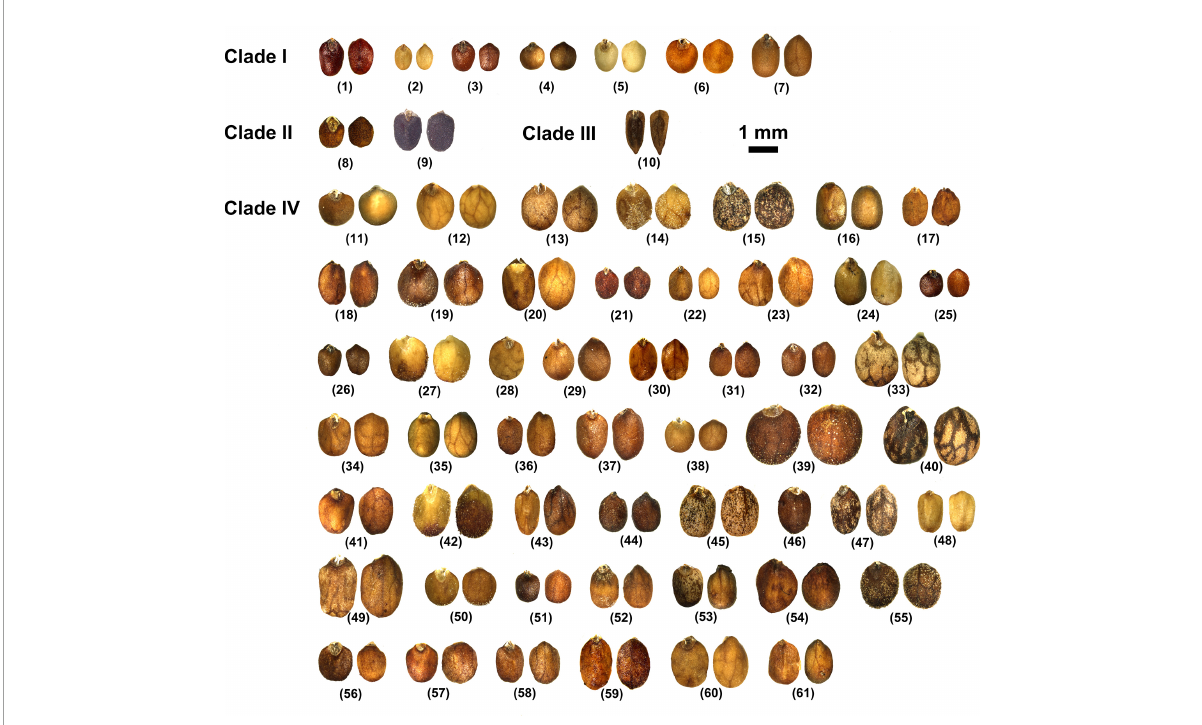
FIGURE3 Nutlet morphology of taxa of Isodon . (1) I. atroruber ; (2) I. lophanthoides var. lophanthoides ; (3) I. lophanthoides var. graciliflorus ; (4) I. oreopilus ; (5) I. phyllopodus ; (6) I. scrophularioides ; (7) I. villosus ; (8) I. ramosissimus ; (9) I. schimperi ; (10) I. ternifolius ; (11) I. adenanthus ; (12) I. albopilosus